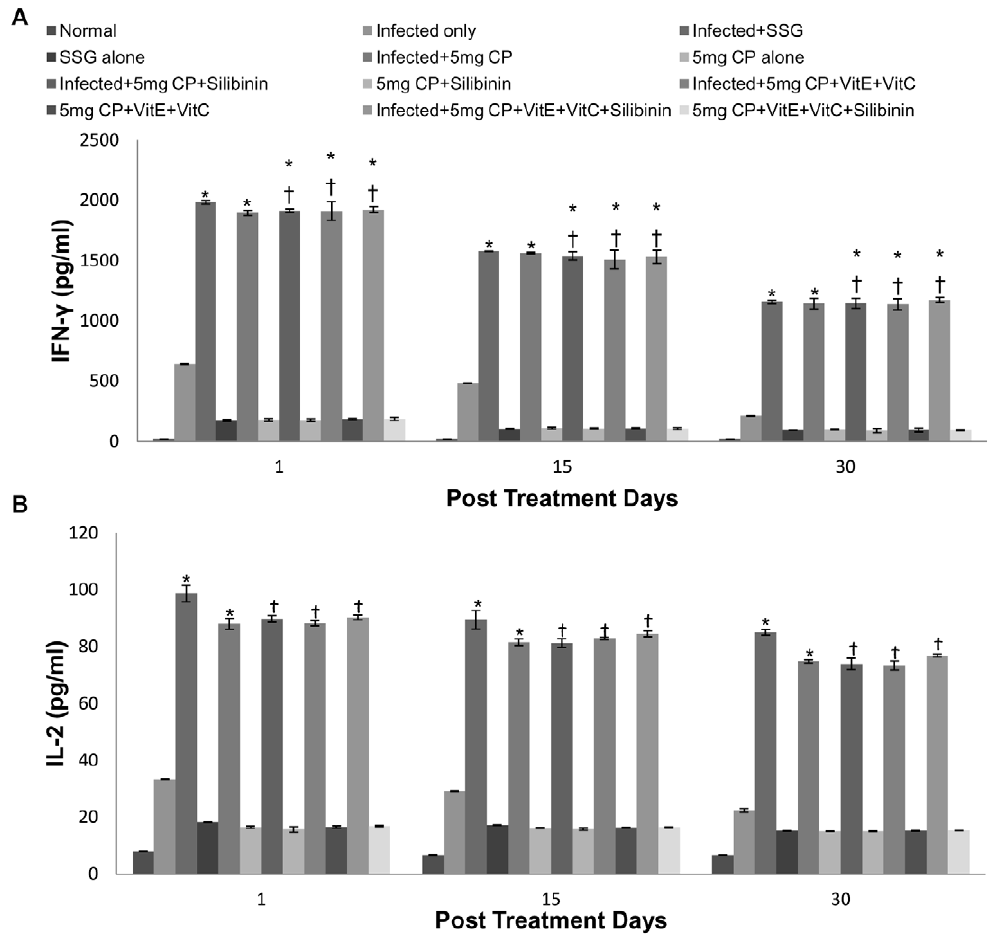
Figure 4. Cytokine levels in culture supernatants of spleen cells of different groups of animals. A- IFN- c , B-IL-2. The data are presented as mean 6 S.D. of six mice per group. * -p value: Infected only vs Infected + SSG/Infected + 5 mg CP/Infected + 5 mg CP + Silibinin/Infected + 5 mg CP + VitE + VitC/Infected + 5 mg CP + VitE + VitC + Silibinin. { -p value: Infected + 5 mg CP vs. Infected + 5 mg CP + Silibinin/Infected + 5 mg CP + VitE + VitC/ Infected + 5 mg CP + VitE + VitC + Silibinin. *, { -p ,